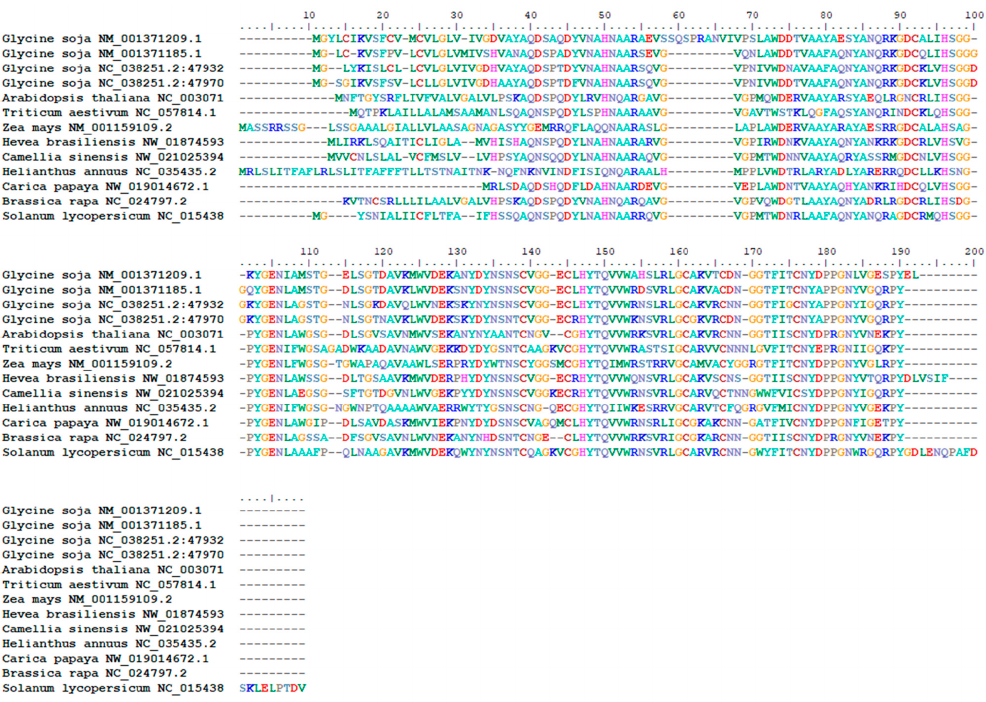
Figure 1. Gene similarity comparison between GmPR1L and multi-species PR1 Family. Glycine soja NM_001371209.1: GmPR1L Target gene; Glycine soja NM_001371185.1: pathogenesis-related protein